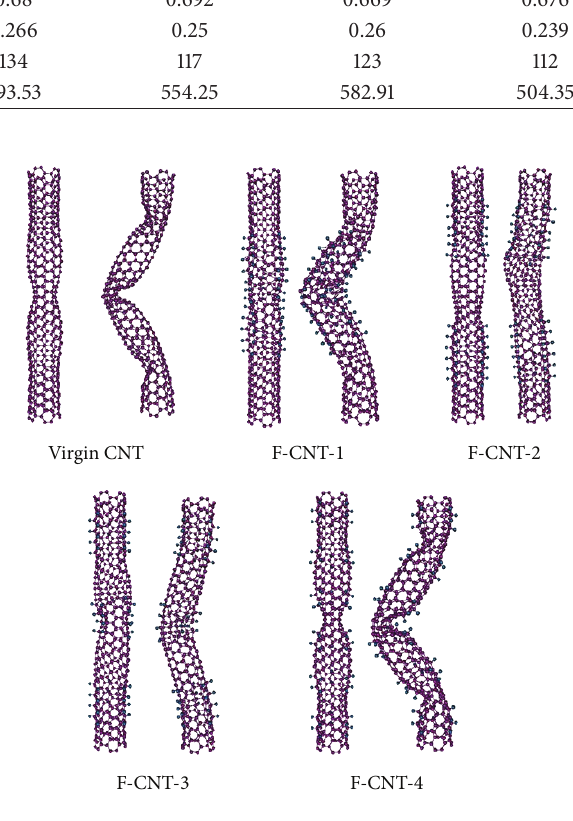
Figure 5: Buckling deformation of CNTs with different functional- ization